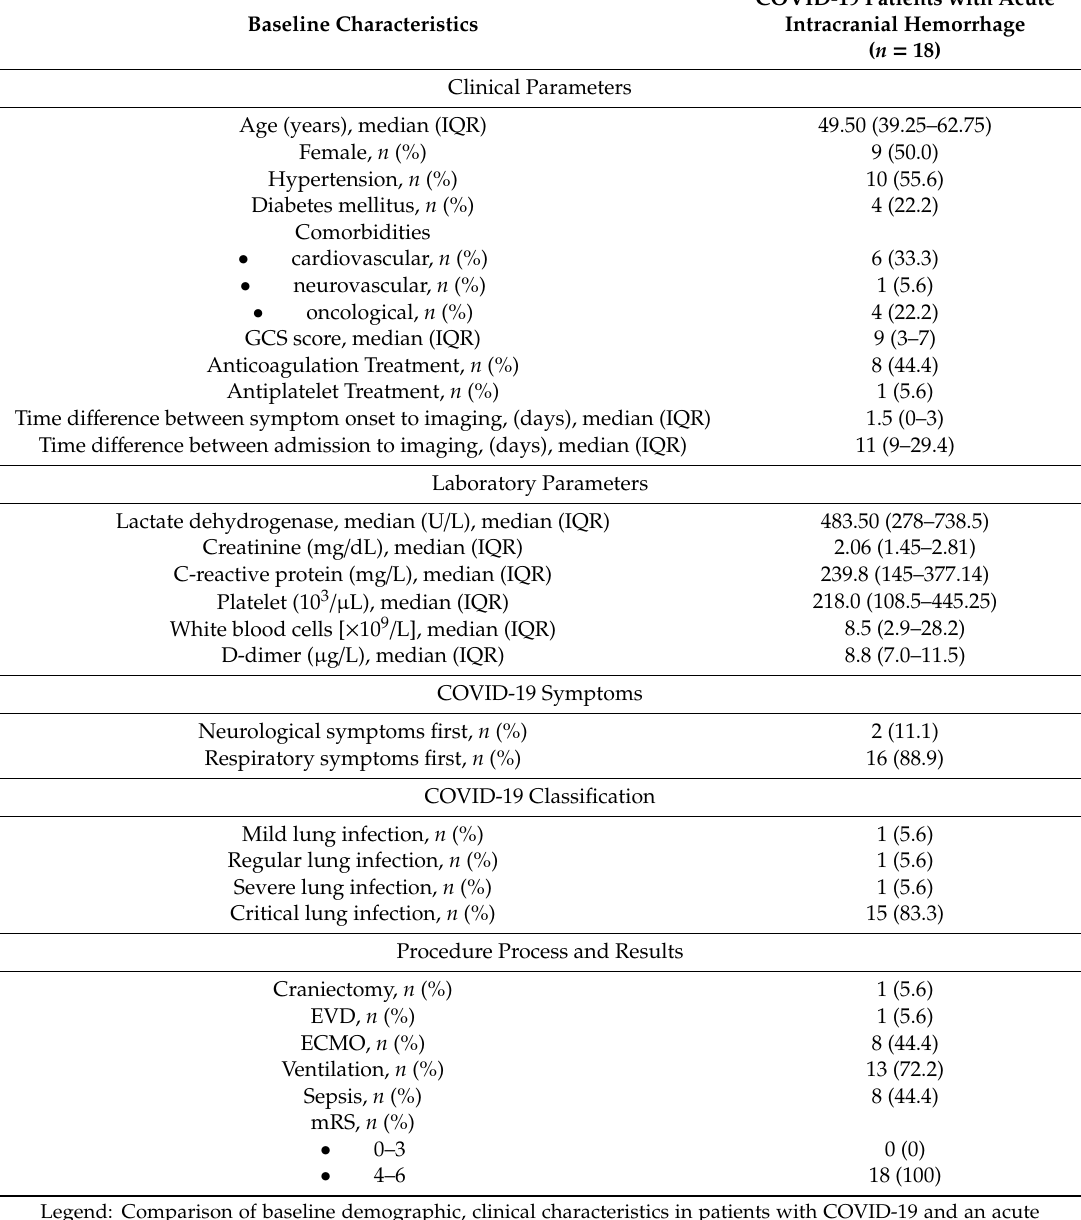
Legend: Comparison of baseline demographic, clinical characteristics in patients with COVID-19 and an acute intracranial hemorrhage. ECMO indicates extracorporeal membrane oxygenation; EVD, extraventricular drainage; GCS, Galsgow Coma